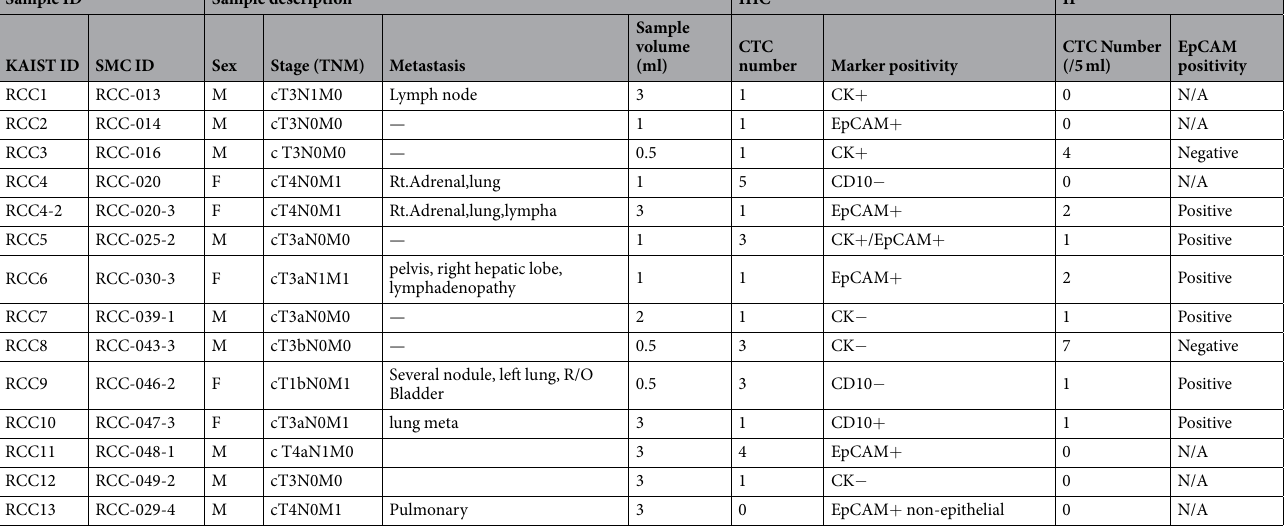
Table 3. The description of the 13 circulating tumor cell positive cases identified by immunocytochemical (ICC) staining, and its comparison with immunofluorescence (IF) staining results.